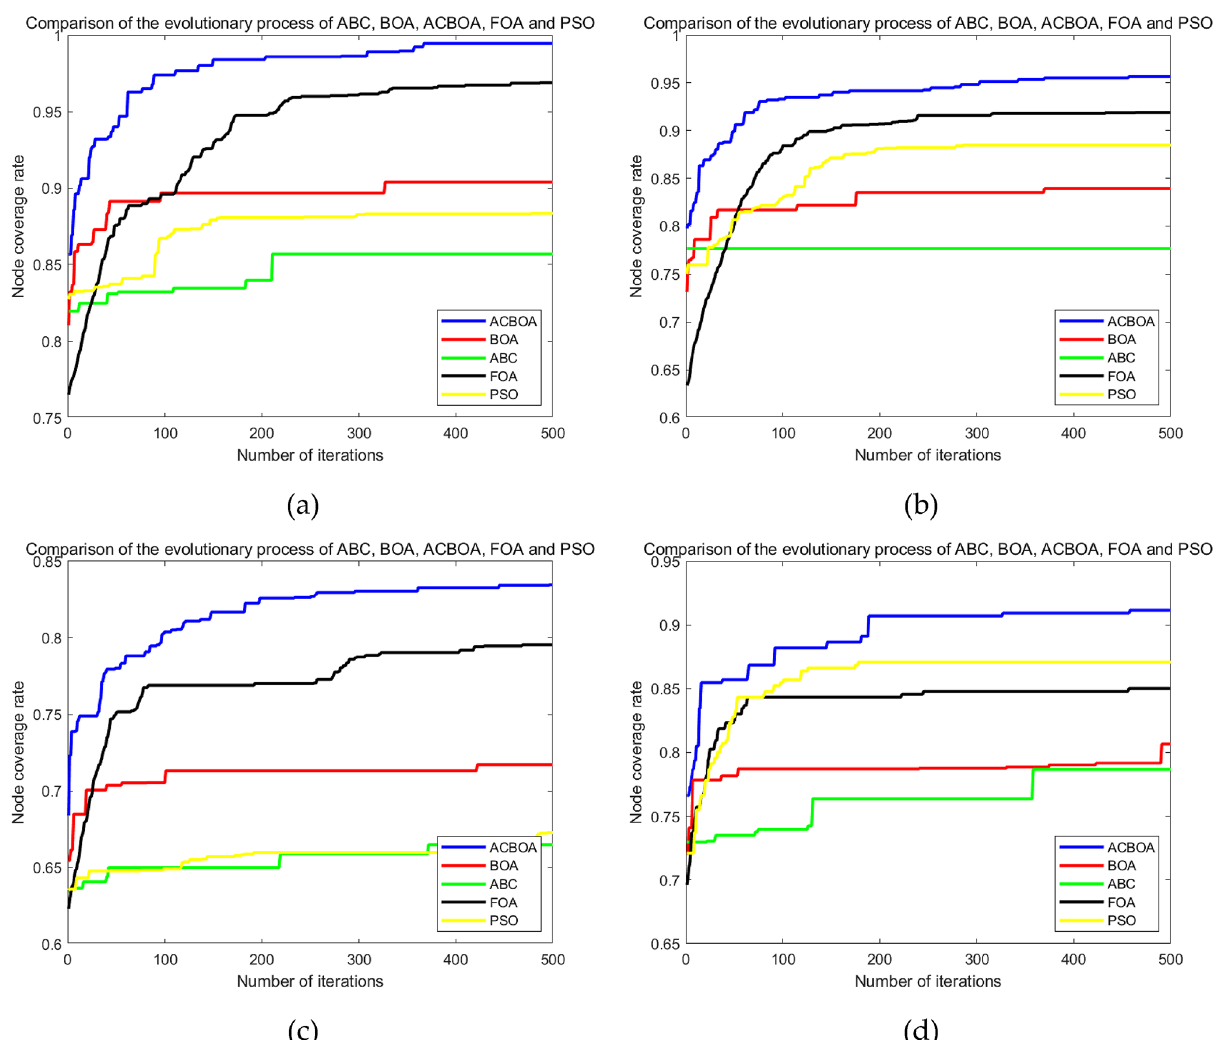
Figure 4. Iterative curves of coverage optimization under different conditions ( a ) Restriction 1, ( b ) Restriction 2, ( c ) Restriction 3, ( d ) Restriction